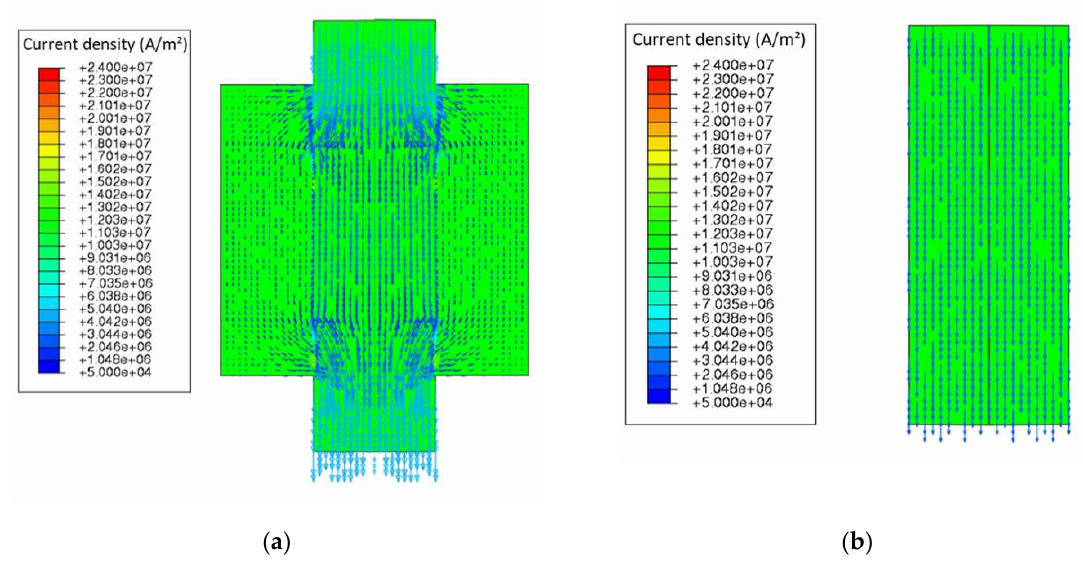
Figure 2. Current vector field for a sample ( a ) with a die and ( b ) without a die.